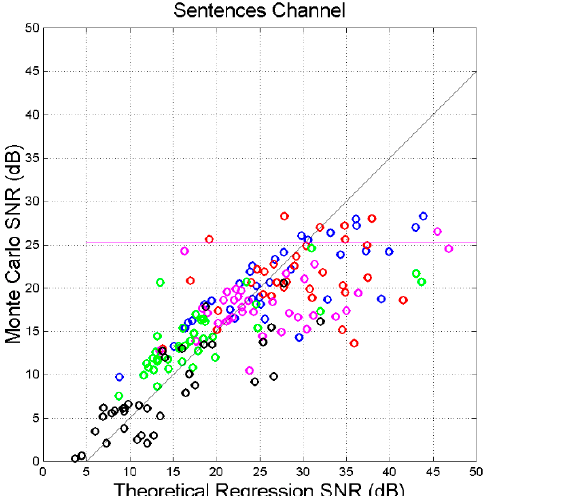
Figure 10. ( Left panel ): Scatter plot between the theoretical total signal-to-noise ratio Γ dB , th and Γ dB , ex for the indicated cross-channels. ( Right panel ): Difference Γ (cid:3031)(cid:3003),(cid:3047)(cid:3035) (cid:3398) Γ (cid:3031)(cid:3003),(cid:3032)(cid:3051) , i.e., ratio (ex ‐ pressed in dB) between the noise power in the experimental channel and that in the theoretical channel. Color key : blue = Mt vs. Mk; red = Mt vs. Lk; magenta = Mt vs. Jh; green = Mt vs. Ac; black = Mt vs. Ap. The magenta line corresponds to Greek self ‐ channel.